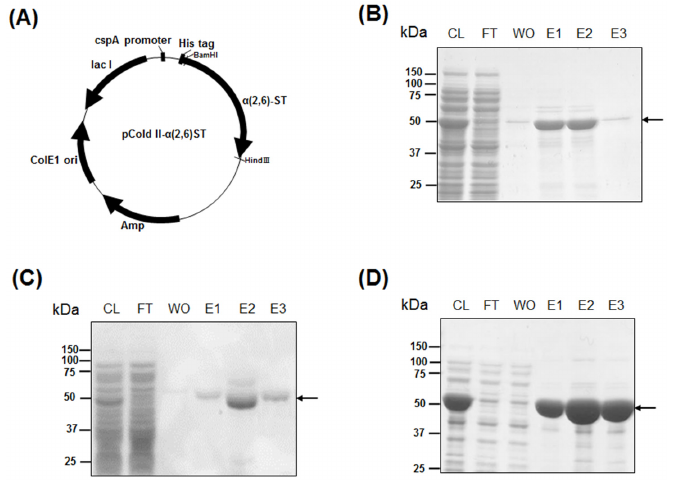
Fig 1. Expression and purification of recombinant α (2,6)-STs in E . coli . Bacterial α (2,6)-ST genes (Pd- ST, P224-ST, and P145-ST) were cloned into a pCold II vector for recombinant expression in E . coli (A). Recombinant Pd-ST (B), P224-ST (C), and P145-ST (D) were purified using His-tag affinity chromatography and analyzed using SDS-PAGE. CL: soluble fraction of cell lysate, FT: flow-through fraction, WO: wash-out fraction, E1-3: eluted fractions. Purified α (2,6)-ST protein bands are indicated by the